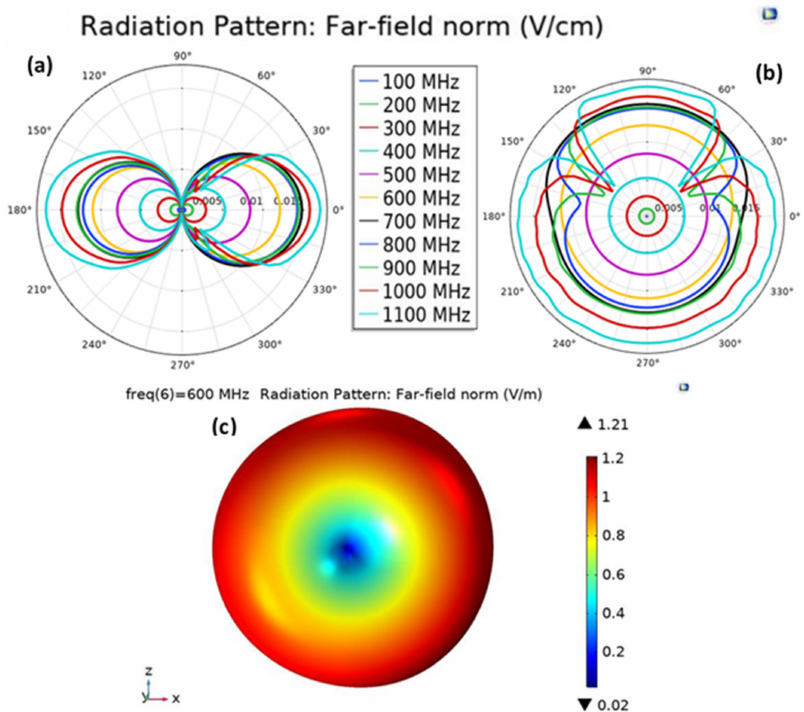
Figure 9. A far-field distribution pattern in sandstone saturated with oil, brine and nanofluid showing ( a ) a polar plot of the side view from the XZ plane (conical cut at theta), ( b ) a polar plot of the top view from the XY plane (planar cut at phi) and ( c ) a 3D polar plot at 600